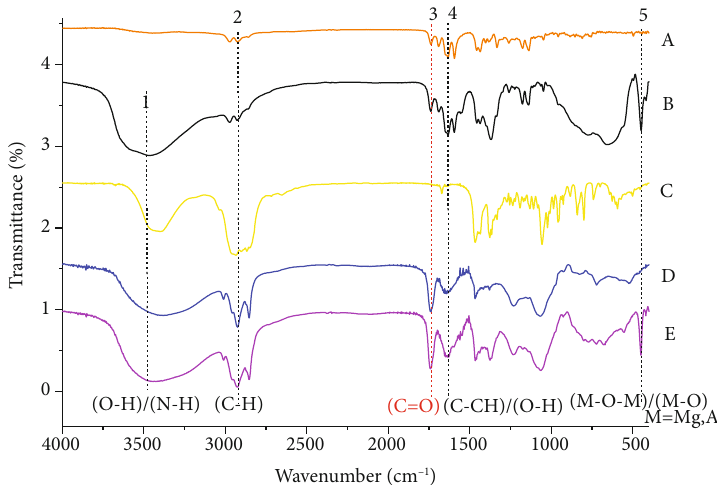
Figure 5: FTIR spectra of GA (a), GA-LDH (b), cholesterol (c), lecithin (d), and GA-LDH/LS